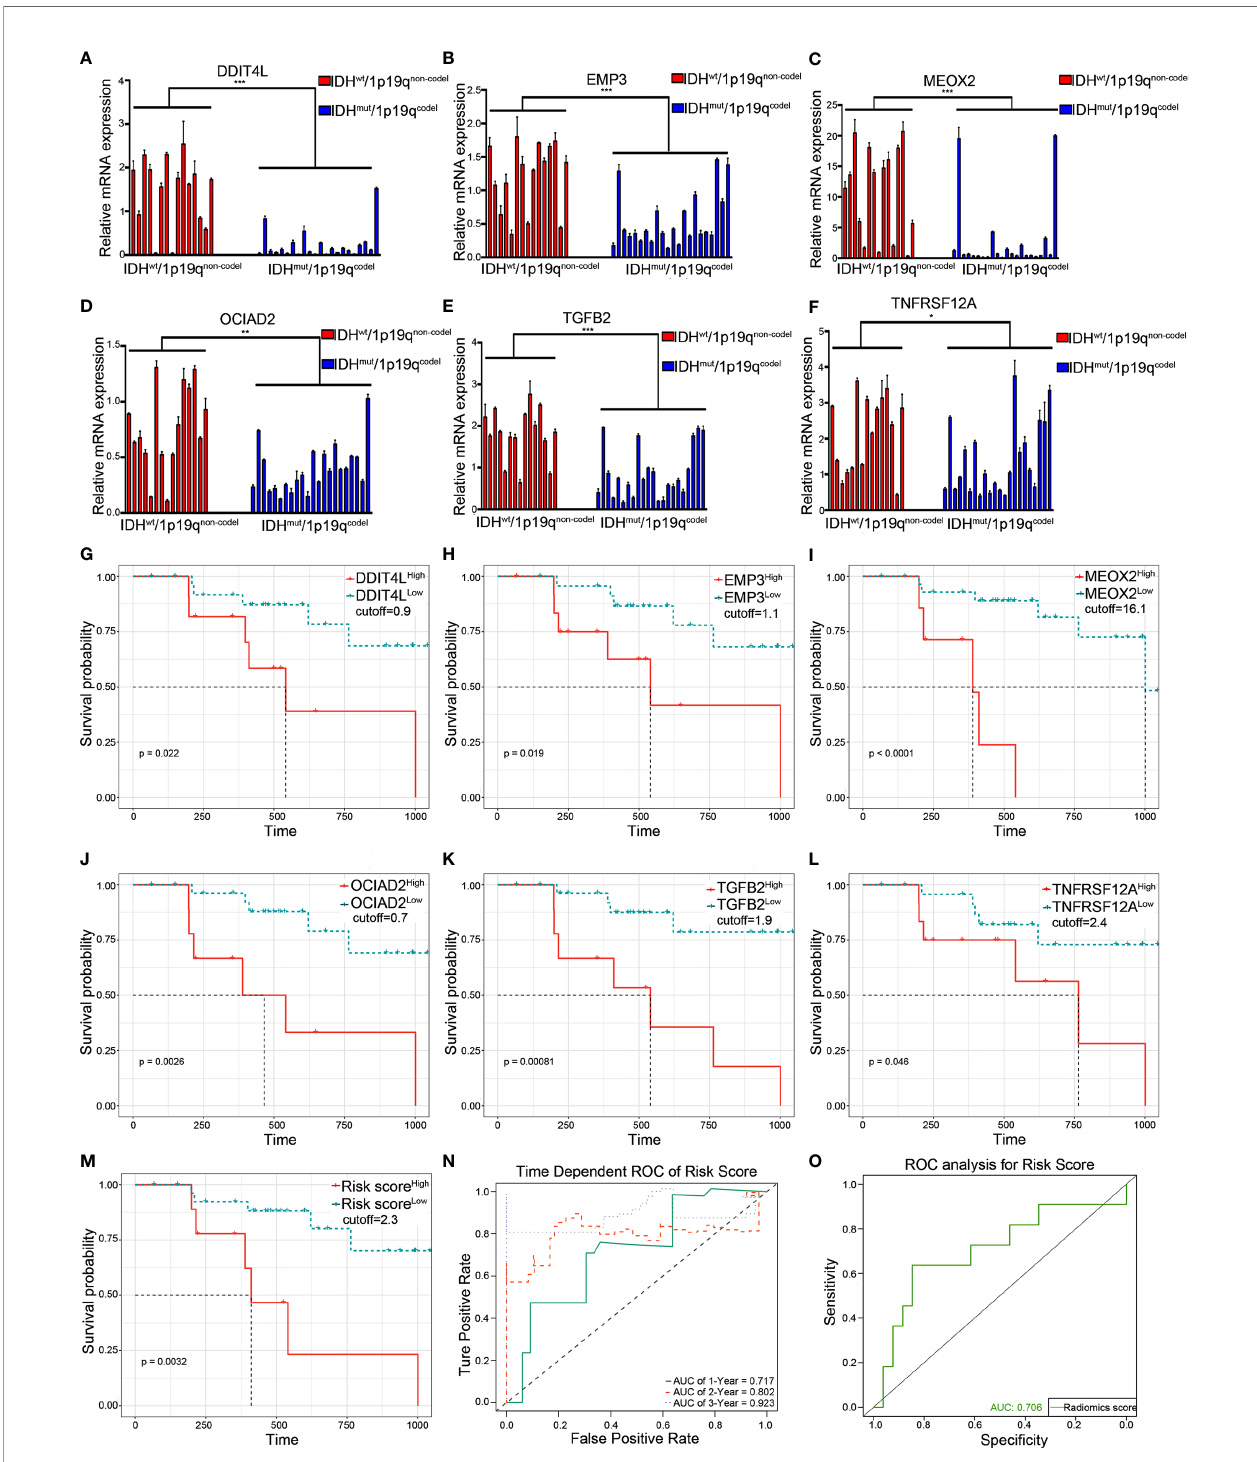
FIGURE 7 | Validation of the transcriptional risk score and radiomics risk score using qRT-PCR in clinical samples. (A – F) qRT-PCR analysis for measuring the relative mRNA expression of risk gene cluster in 37 LGG tumor tissues grouped by IDHmut/1p19qcodel and IDHwt/1p19qnon-codel (*** p < 0.001, ** p < 0.01, and * p < 0.05, with t test, n = 3). (G – M) The Kaplan – Meier survival curves were performed in transcriptional prediction risk score, DDIT4L expression, EMP3 expression, MEOX2 expression, OCIAD2 expression, TGFB2 expression, and TNFRSF12A expression; the optimal cutoff value was derived from X-tile using qRT-PCR data in our clinical samples, respectively (all p < 0.05, with log-rank test). (N) The time-dependent ROC curve analysis for transcriptional risk score during 1, 2, and 3 years in the clinical cohort. (O) The ROC curve analysis of radiomics risk score in the clinical cohort. qRT-PCR, quantitative